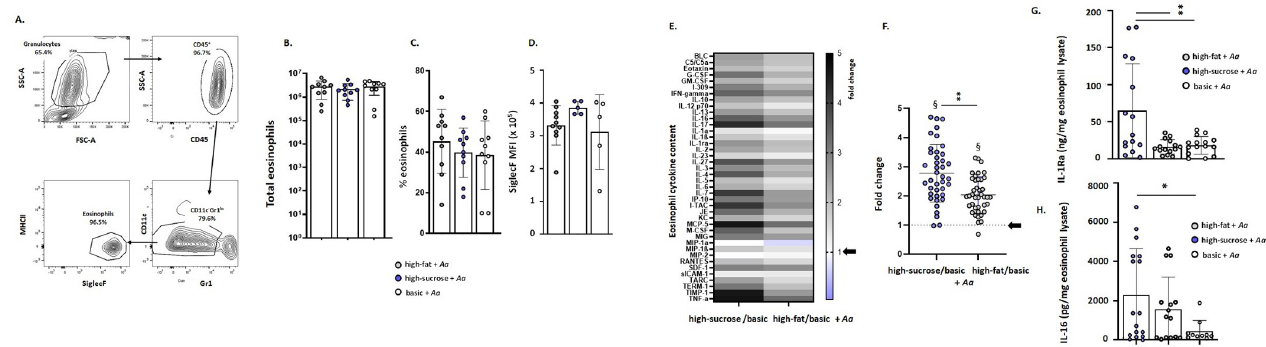
Fig 4. Cytokine-enriched eosinophils isolated from the lungs of Aa -challenged mice maintained on a high-sucrose diet. Mice were maintained on specific diets and challenged with Aa as shown in Fig 2A. ( A ) Gating strategy used to isolate eosinophils from mouse lung tissue. As shown, FACS-isolated eosinophils are live, high forward/side scatter (granulocyte gate), CD45 + CD11c - Gr1 lo MHCII - SiglecF + cells. (B) Total eosinophils, (C) percent eosinophils, and (D) eosinophil Siglec F MFI identified in mouse lung tissues. ( E ) Heatmap and ( F ) semiquantitative analysis of the cytokine contents of FACS-isolated eosinophils from lung tissue of Aa -challenged mice. The data shown are ratios of the cytokine contents of eosinophils isolated from lung tissue of Aa -challenged mice maintained on high-fat or high-sucrose diets normalized to signals obtained from eosinophils isolated from Aa -challenged mice maintained on the basic diet, n = 5 mice per group as described in the Methods. Arrows indicate no increase over signal detected in mice maintained on the basic diet (fold change = 1.0). Mean and SD for all cytokines are as shown in (F) at 2.8 ± 0.98 (high-sucrose/basic) and 2.0 ± 0.63 (high-fat/basic); �� p < 0.01 (high-sucrose/basic vs . high-fat/ basic, Mann-Whitney U-test; § p < 0.001 vs . theoretical mean (= 1.0), one-sample t-tests. See S3 Fig for additional information. ( G) IL-1Ra (ng/mg lysate) and ( H ) IL-16 (pg/mg lysate) of eosinophils isolated from Aa -challenged mice on high-sucrose, high-fat, or basic diets ( � p < 0.05, �� p < 0.01 between groups as shown, 1-way ANOVA with Tukey’s post hoc